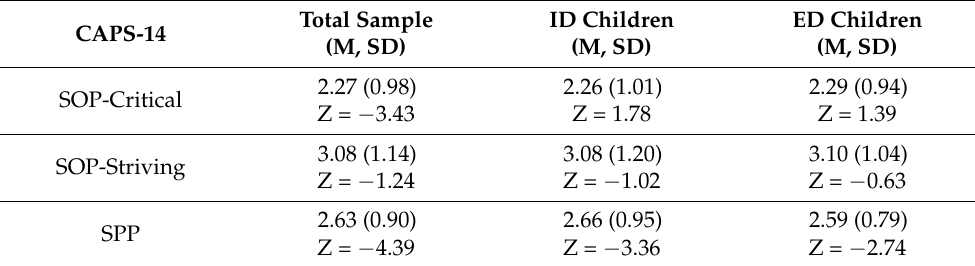
Table 1. Children’s perfectionism scores.